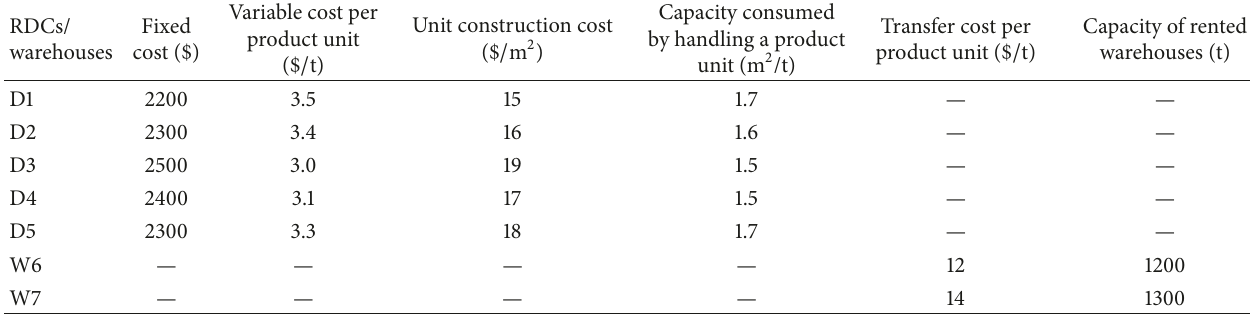
Table 7: Relevant parameters for the five potential RDCs and two warehouses.